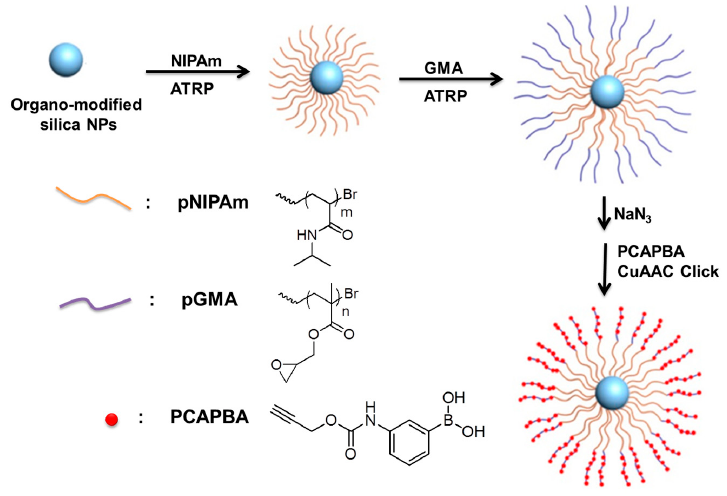
Figure 3. Preparation of boronic acid functional silica-based nanocomposites via the combination of surface-initiated ATRP and CuAAC click reaction. Adapted with permission from [31]. Copyright © 2017 by the American Chemical Society.